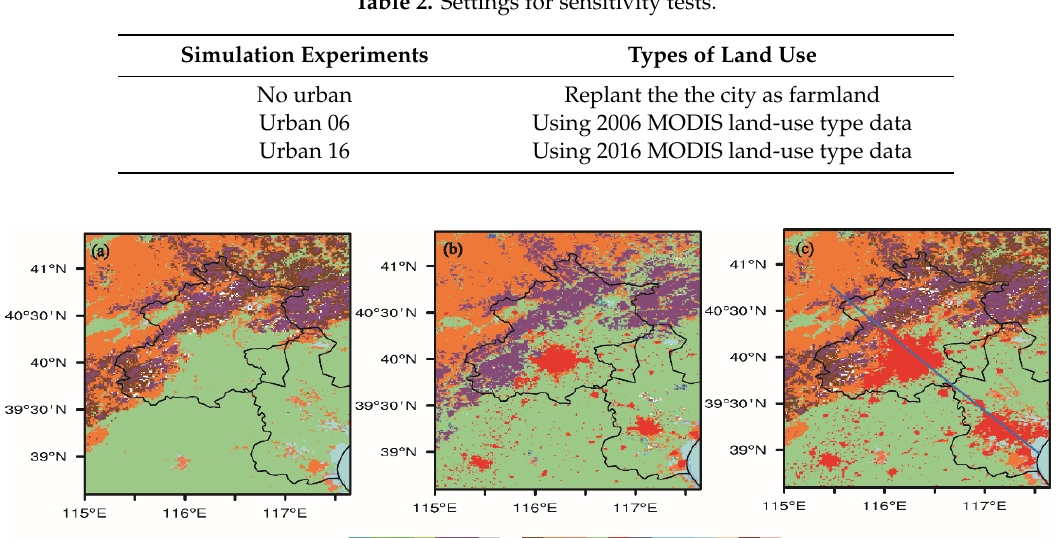
Table 2. Settings for sensitivity tests.